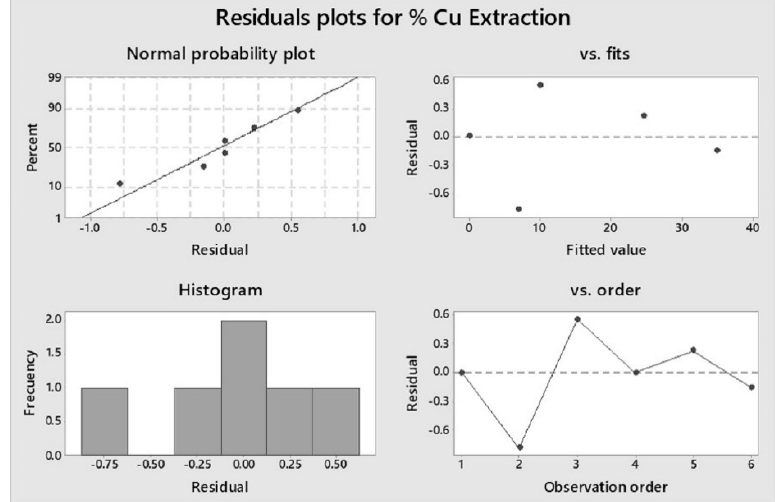
Figure 9. Residual plots for copper dissolution.